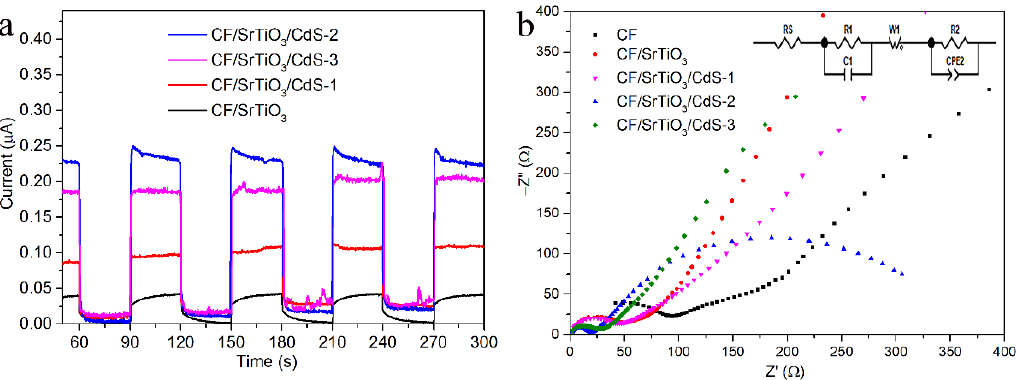
Figure 13. Transient photocurrent response spectra ( a ) and impedance spectra ( b ) of different samples.